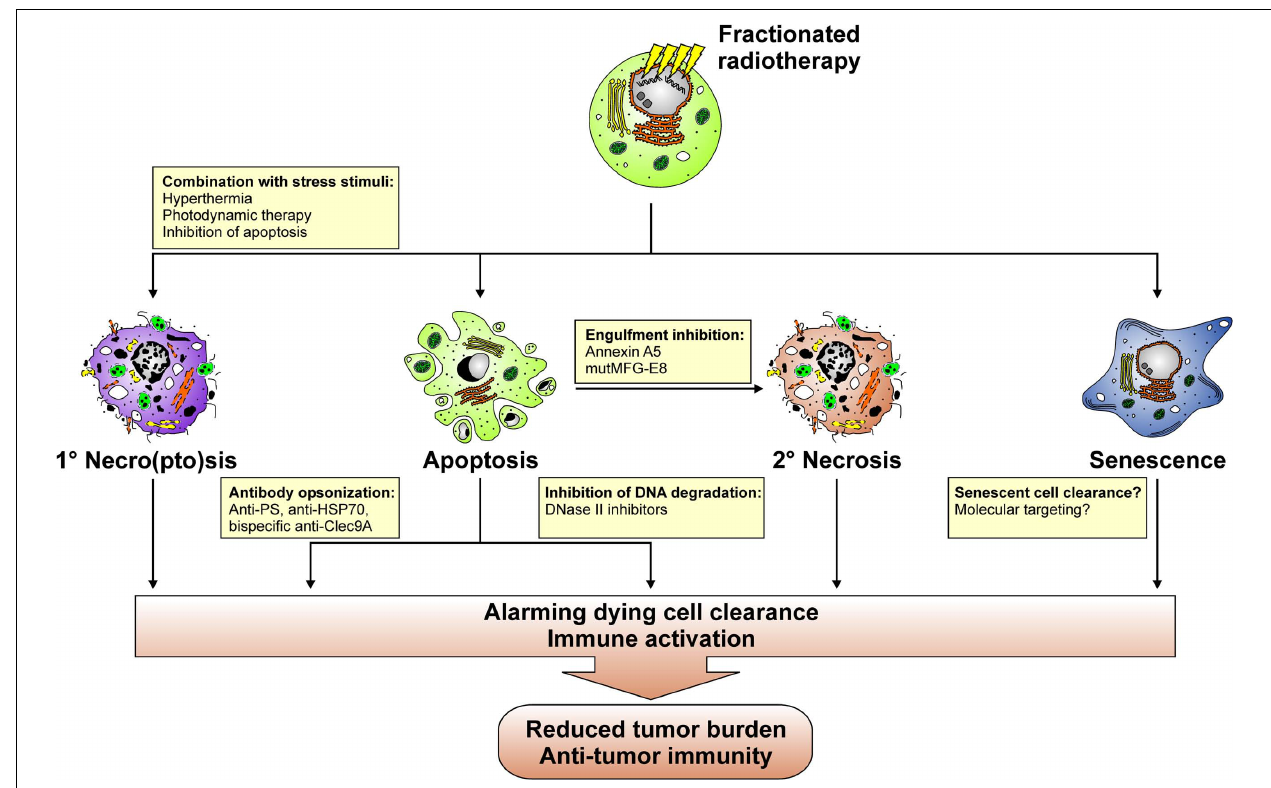
FIGURE 6 | Putative approaches with which the process of dying cell clearance can be instrumentalized in order to induce anti-tumor immunity in the context of fractionated